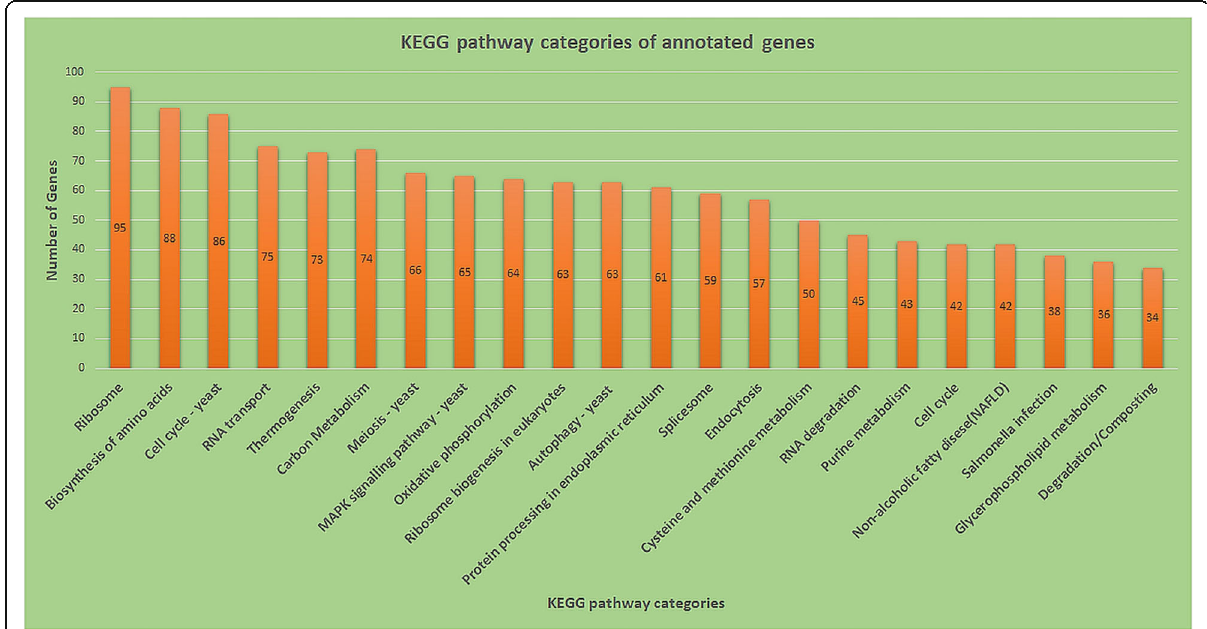
Fig. 1 Major KEGG pathway categories of annotated genes from the M. guilliermondii strain